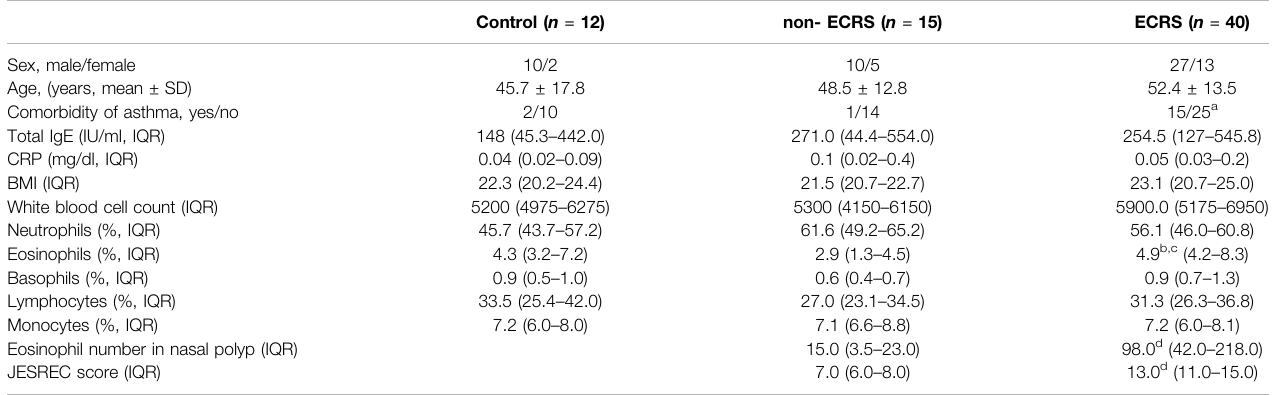
TABLE 1 | Characteristics of the